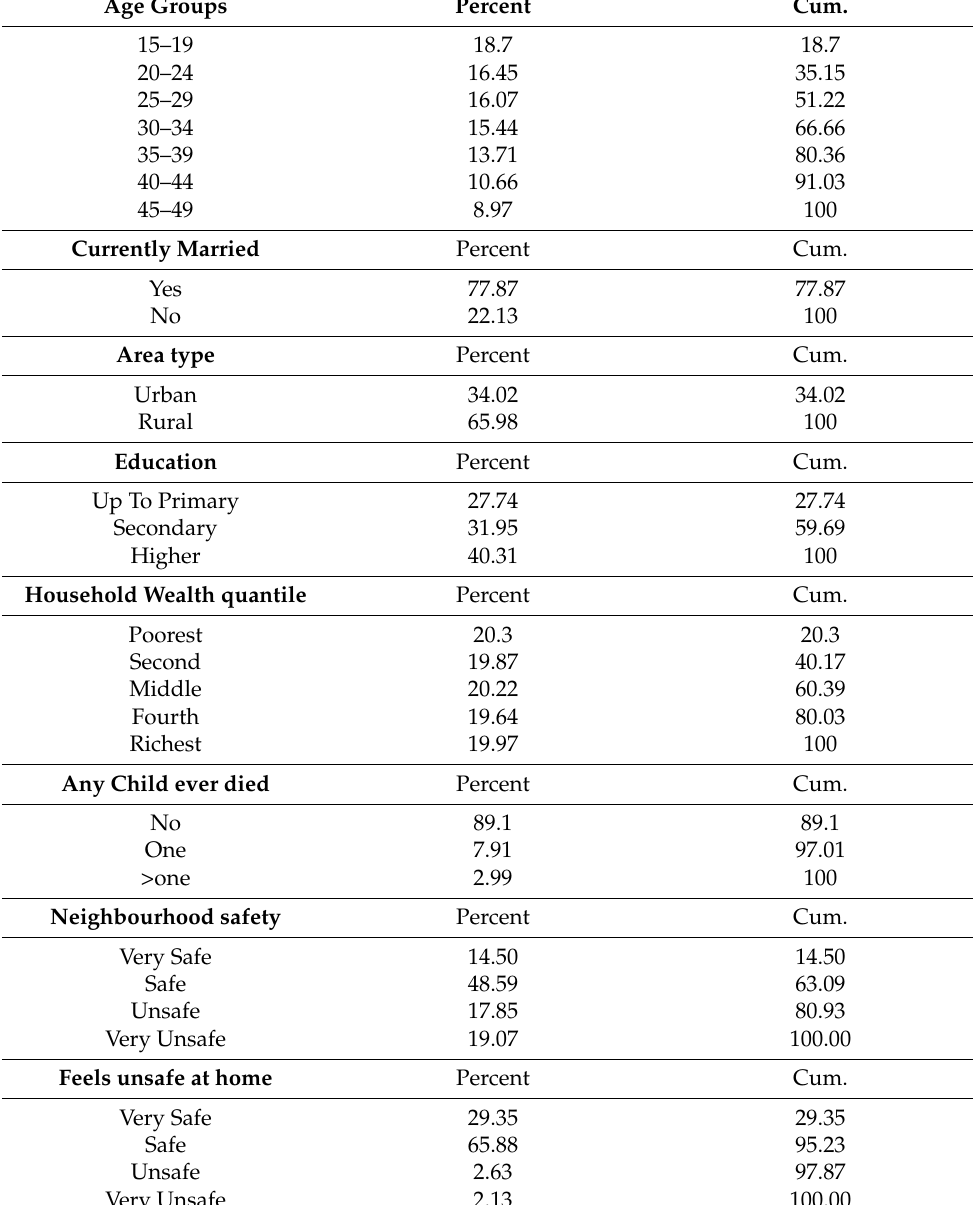
Table A1. Basic sociodemographic characteristics of the